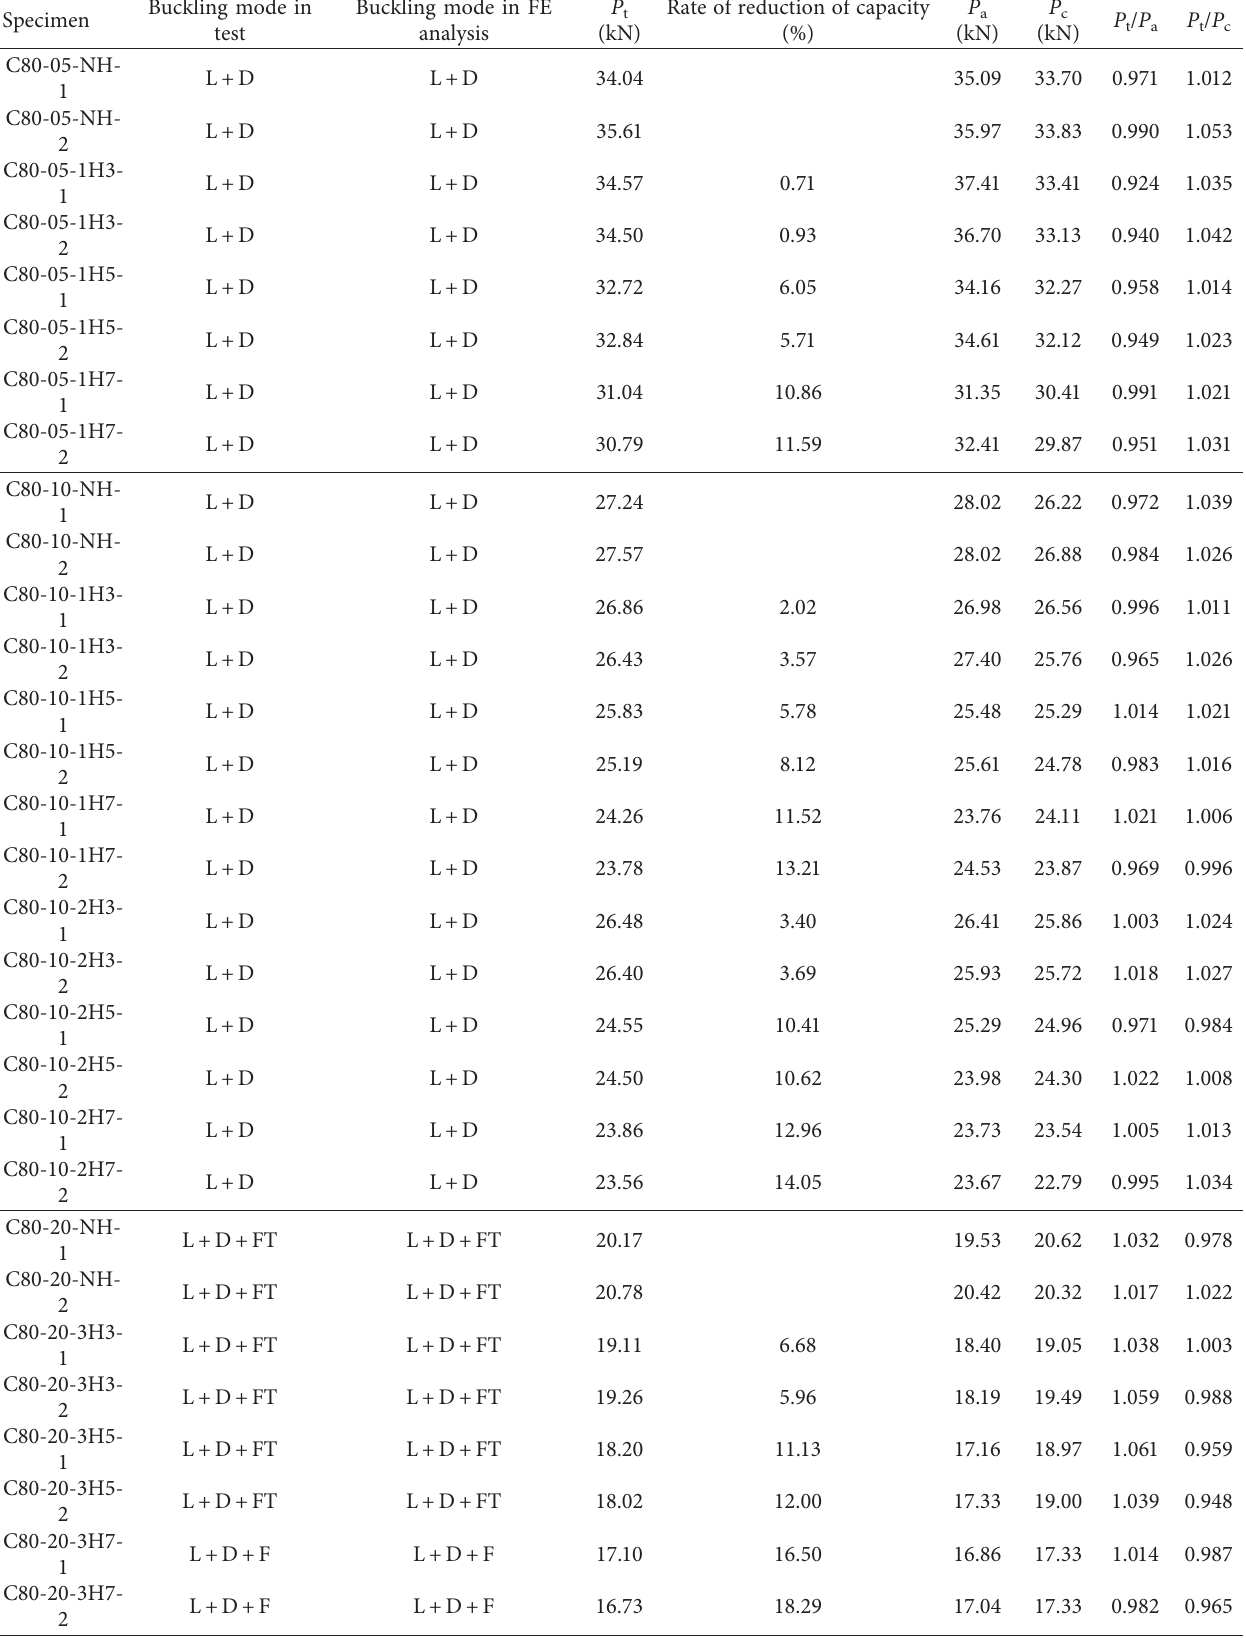
Table 2: Comparison on failure modes and failure loads of